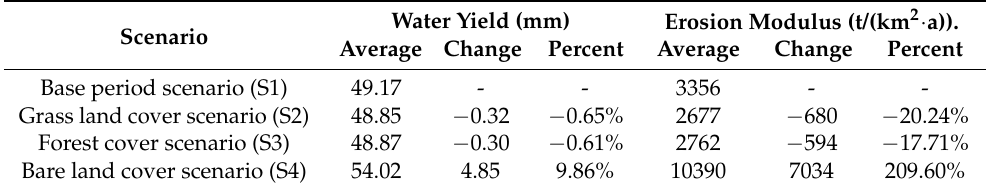
Table 3. Simulation results for average annual water yield and sediment yield for four scenarios. Water Yield (mm) Erosion Modulus (t/(km 2 · a)). Scenario Average Change